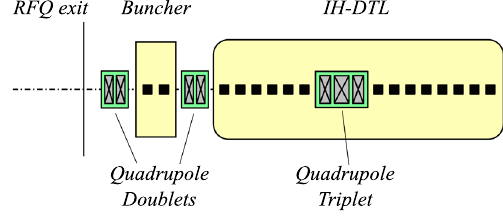
FIG. 1. Layout of the buncher and IH-DTL section.